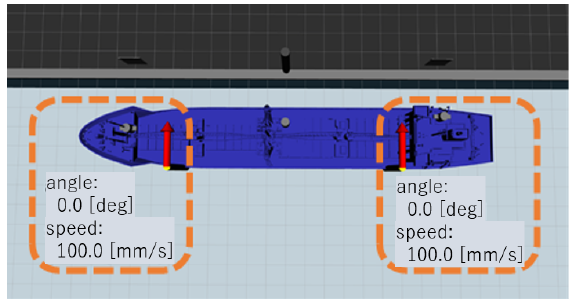
Figure 8. Visualization interface to visualize the hull positioning and its velocity